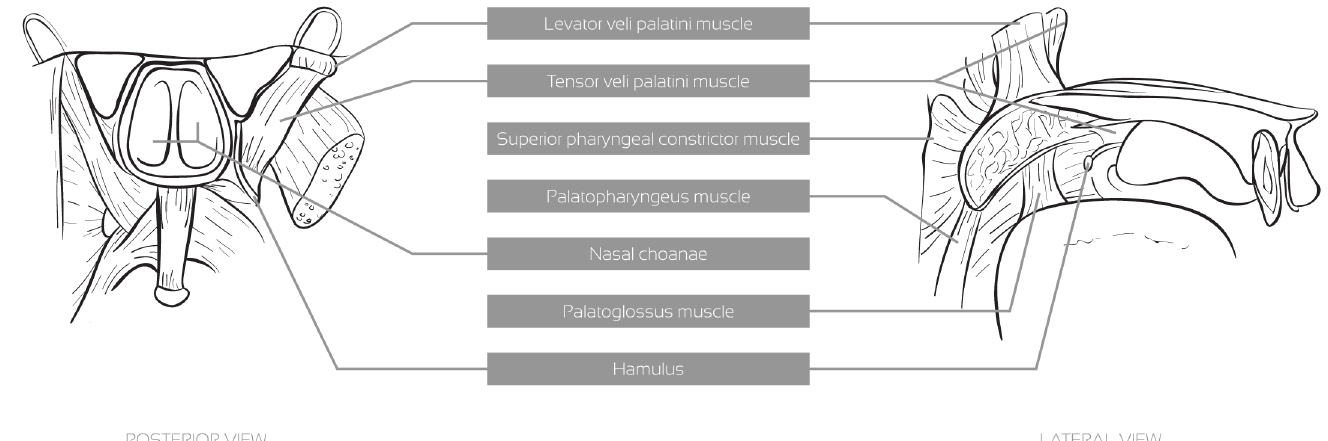
Fig 1. Muscles of the soft palate from posterior (left), and the side (right)